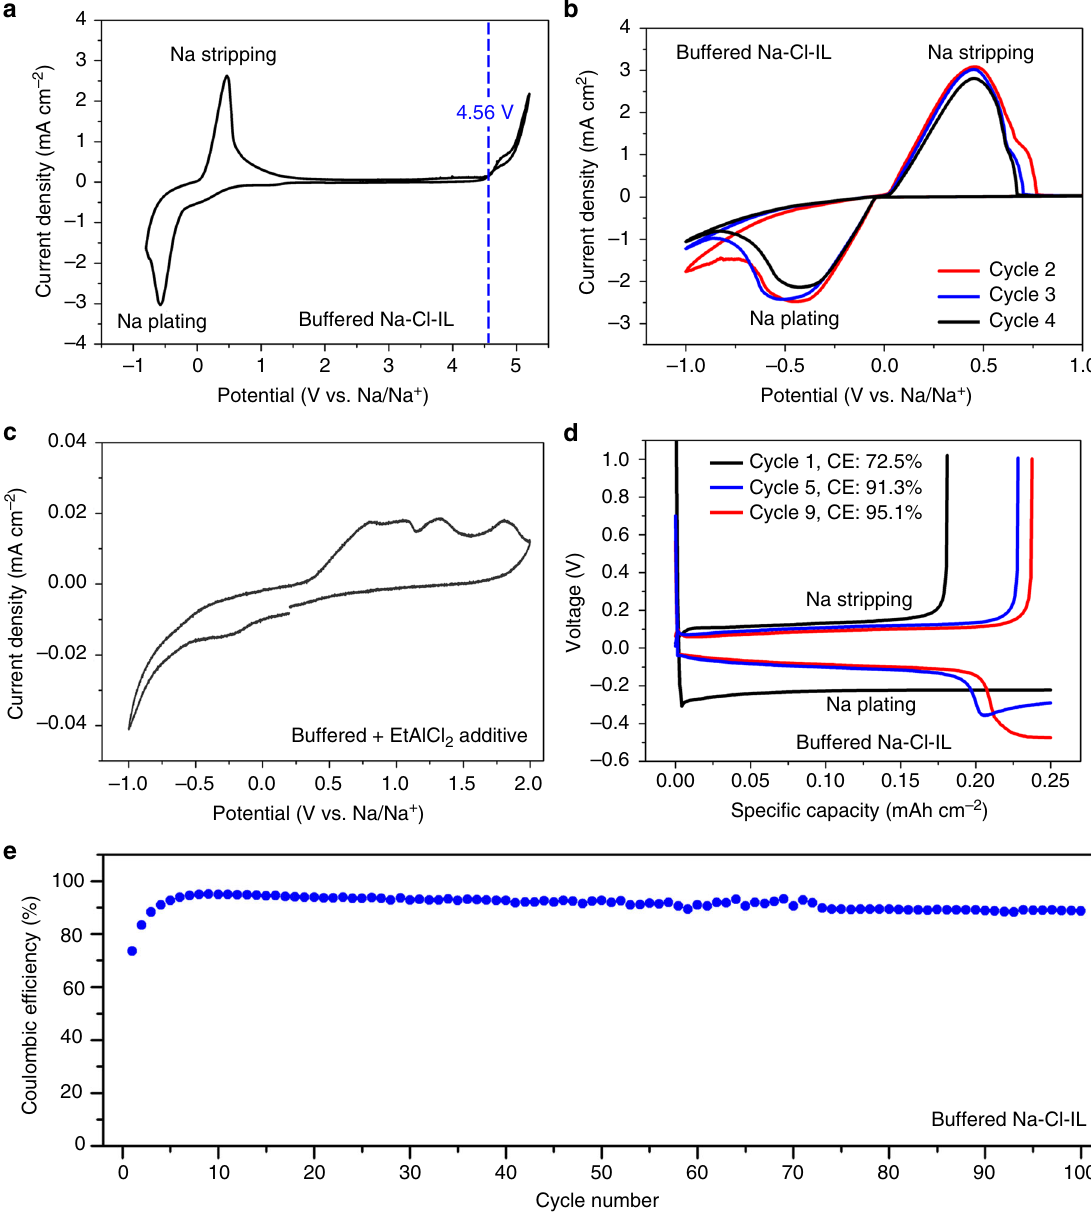
Fig. 2 Electrochemical properties of the buffered Na – Cl – IL electrolyte. a Linear sweep voltammetry pro fi le of buffered Na – Cl – IL electrolyte. Working electrode, carbon fi bre paper. Counter and reference electrode, Na foil. Scan rate, 2 mV s − 1 . b , c CV curves of Na/Pt cells using buffered + EtAlCl 2 additive and buffered Na – Cl – IL electrolyte at a scan rate of 2 mV s − 1 , respectively. d Na plating/stripping pro fi les of Na/Pt cells using buffered Na – Cl – IL electrolyte at a current density of 0.5 mA cm − 2 . e Na plating/stripping Coulombic ef fi ciency of a Na/Pt cell using Buffered Na – Cl – IL electrolyte at 0.5 mA cm − 2 . The plating capacity in ( d , e ): 0.25 mAh cm −